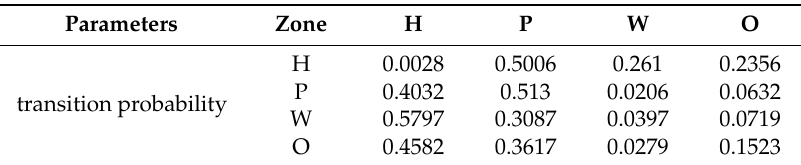
Table 4. Parameters of transition probability.